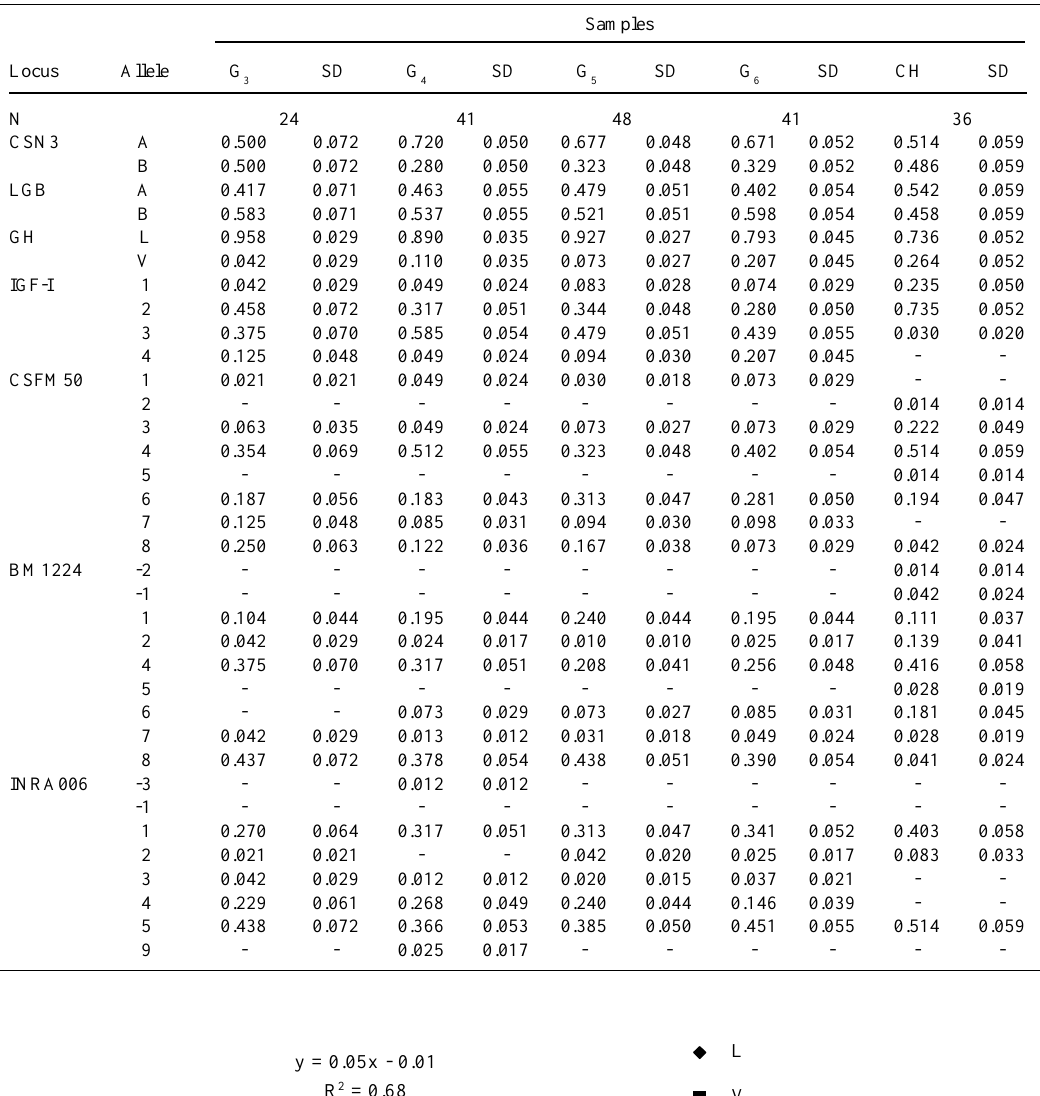
Table II - Allele frequencies and standard deviations (SD) estimated in Canchim generation classes and Charolais (CH).